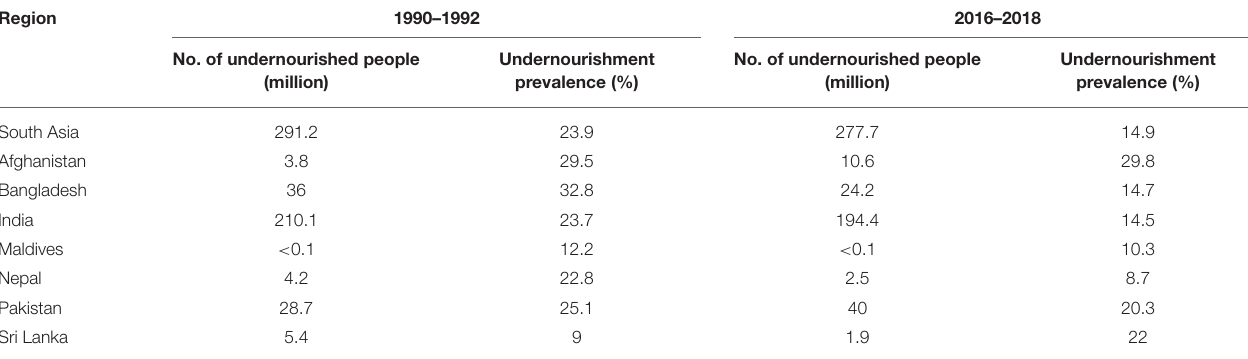
TABLE 1 | Undernourishment trends in South Asian countries.